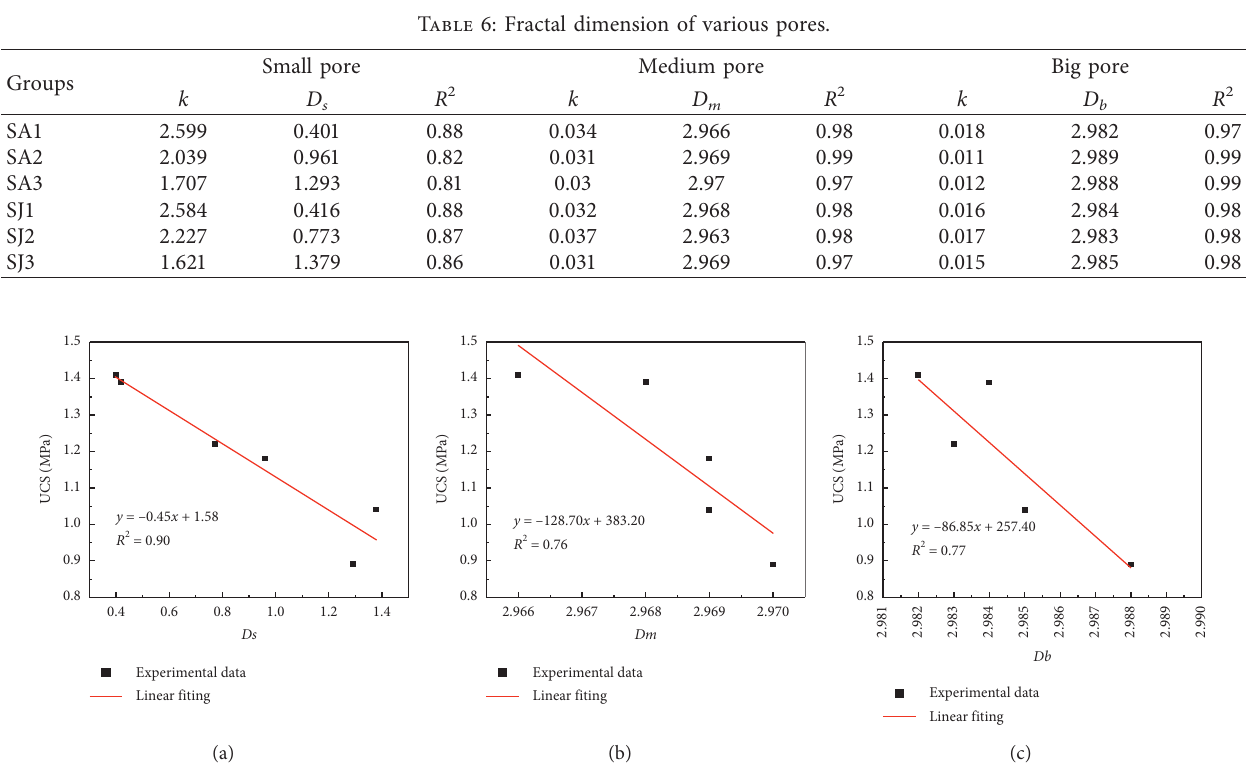
Figure 10: The relationship between UCS and the fractal dimension of various pores.